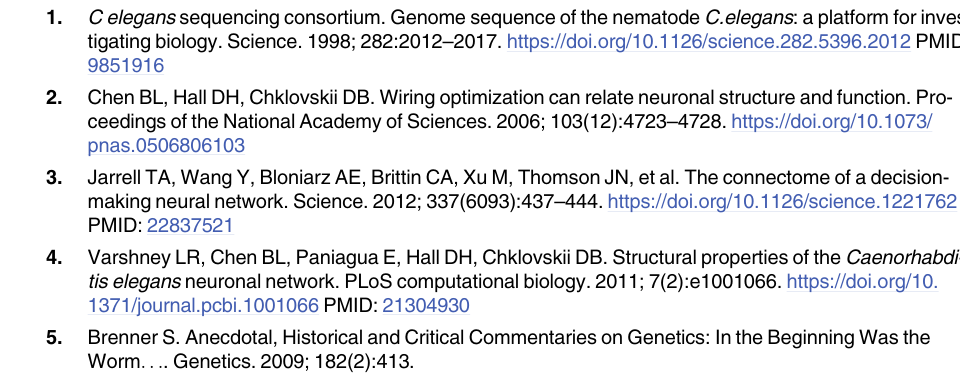
S7 Fig. RMD neuron simulation. A) Steady-state I-V curve for double Ca 2+ channels knockout . I-V curves are calculated by averaging the current in the last 5 ms of each voltage step. The voltage clamp protocol consists in multiple voltage steps between -90 mV and -10 mV. The step duration is 1300 ms and the holding potential is V calcium sensitivity analysis. Simulated response of RMD neuron at different values of τ 28). The stimulation protocol consists in a 10 pA current step with a duration of 50 ms (hold- ing current I = 0 pA). For clarity, in this panel we show an enlargement of the repolarization h phase of the response, since the slight variation of the response can mostly be observed within this